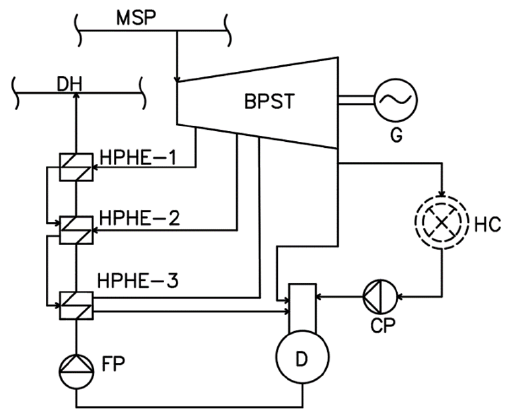
Figure 1. The scheme of steam turbine unit with BPST P-50-130/13 (Case 1): MSP—main steam pipe;